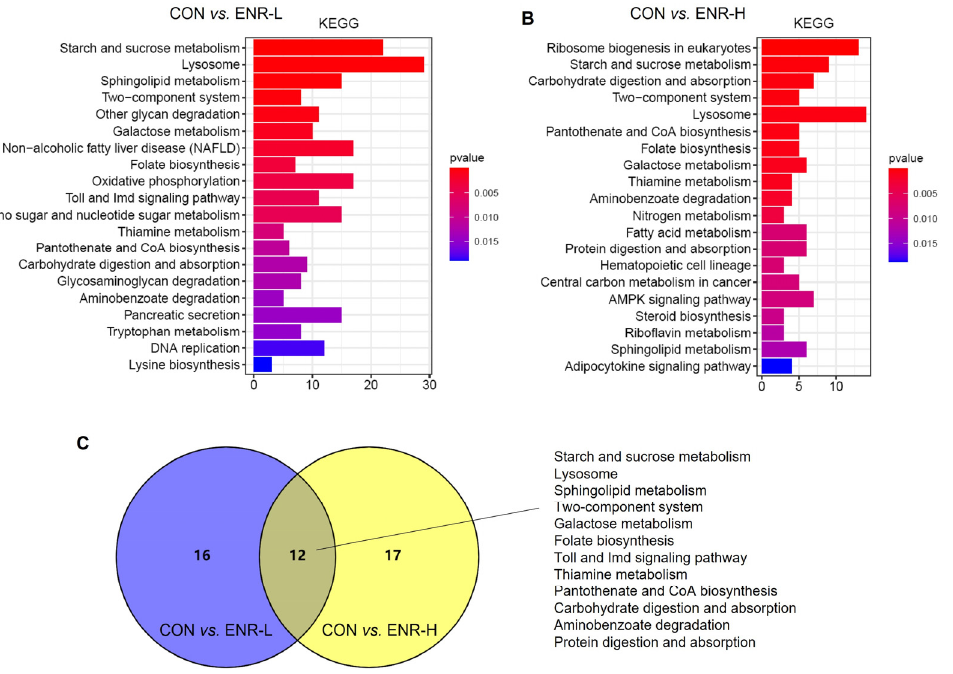
Figure 5. Kyoto Encyclopedia of Genes and Genomes (KEGG) pathway enrichment analysis of DEGs in E. sinensis hepatopancreas samples following different exposure doses of enrofloxacin. Colors represent p -values. The x-axis represents the number of genes annotated in a KEGG pathway. The y-axis represents the KEGG pathway categories. Venn diagrams showing categories of KEGG pathways in E. sinensis hepatopancreas samples following both ( A ) low and ( B ) high exposure doses. ( C ) Enrichment, following KEGG analysis, of DEGs of the system-level biological functions affected by both low (blue) and high (yellow) enrofloxacin exposure